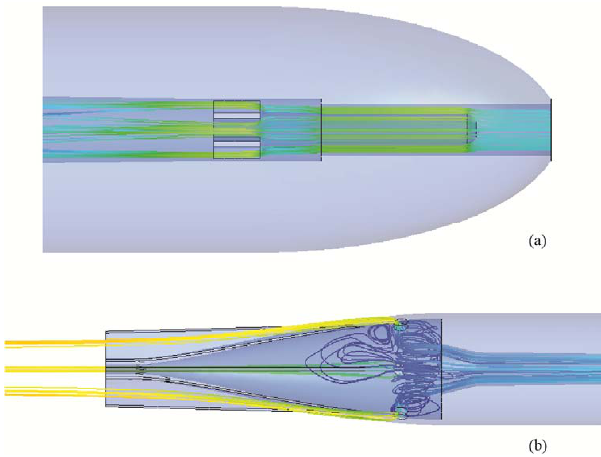
Fig. 3 – Velocity streamlines (a) near the probe inlet and (b) in the probe interior. Fig. 3. Velocity streamlines (a) near the probe inlet and (b) in the probe interior. Table 2. Comparison of calculated drag coefficients with those from Green (1984).